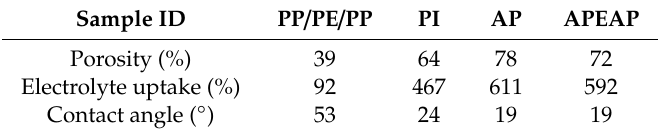
Table 2. Porosity, electrolyte uptake, and contact angle of the samples. Sample